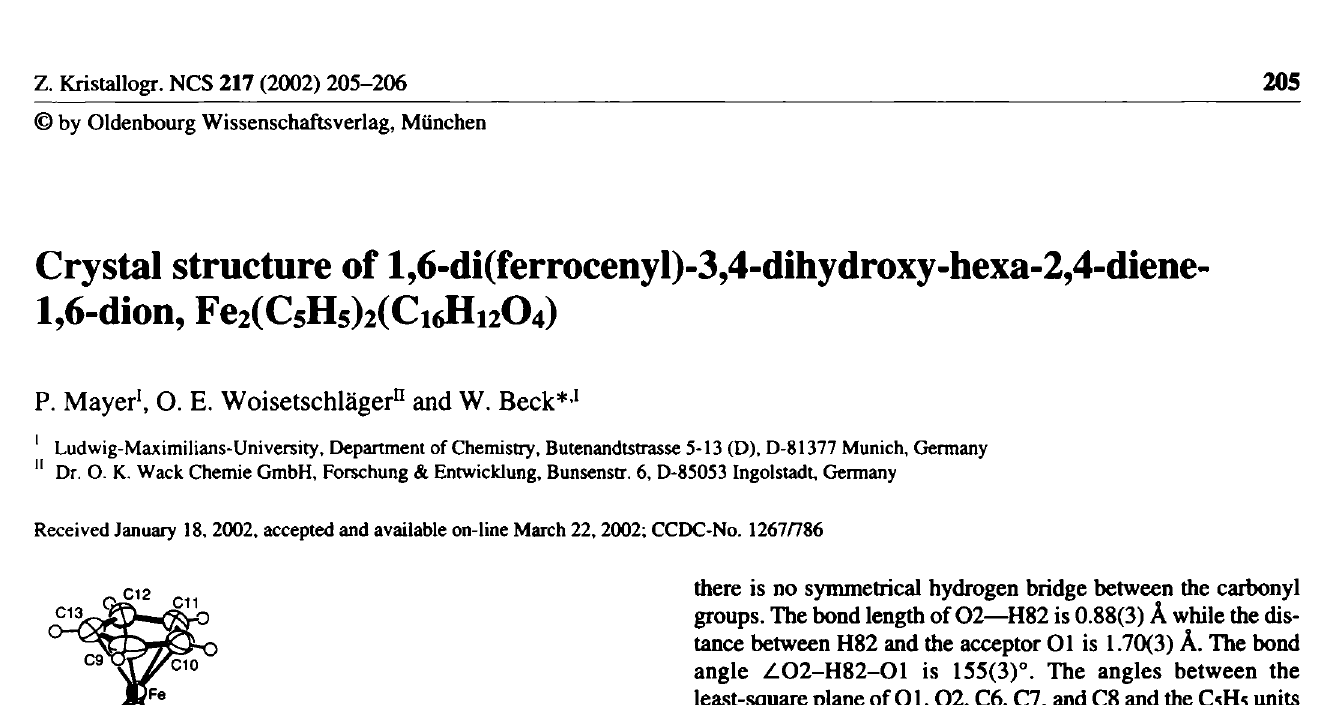
Table 1. Data collection and handling.